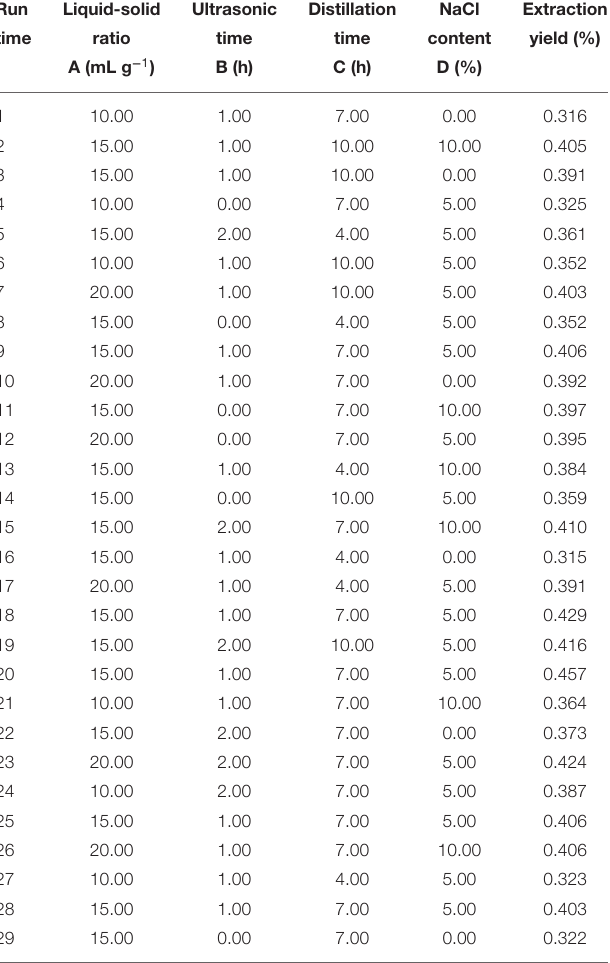
Analysis of the Extraction Yields of SEOs From Different Varieties of Sunflowers The results showed that the extraction yields of SEOs from different varieties of sunflowers were much different ( Table 4